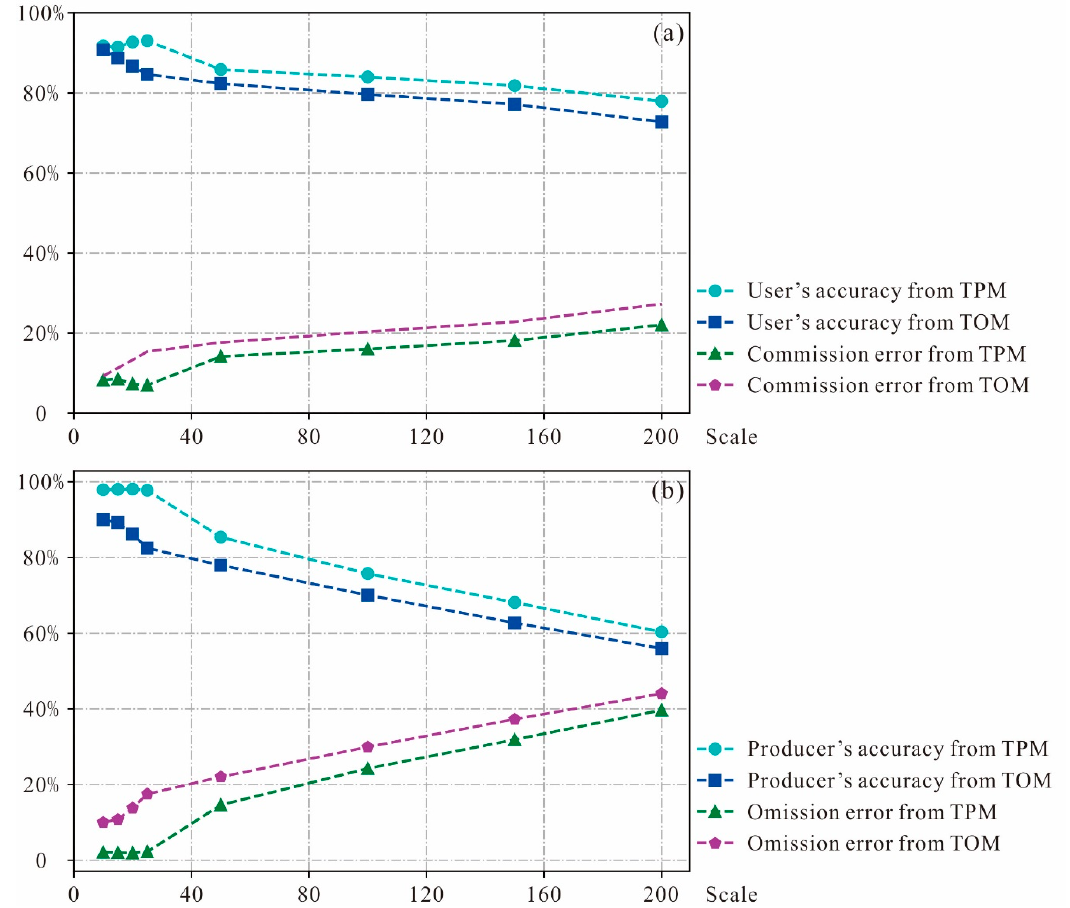
Figure 8. Accuracies of the proposed and the object-oriented method under different segmentation scales taking image H as an example: ( a ) user’s accuracy and commission error, and ( b ) producer’s accuracy and omission error. TPM: the proposed method; TOM: the object-oriented method.